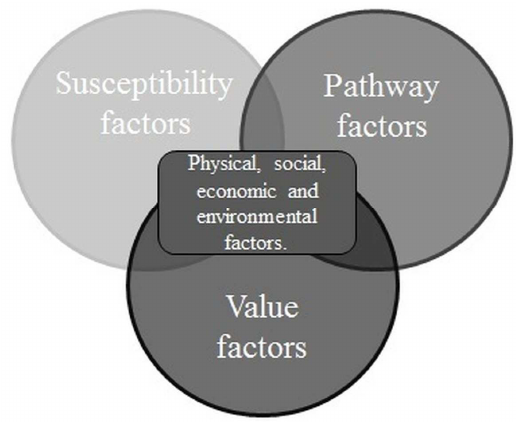
Fig. 2. Conceptualization of vulnerability for the regional vulnera- bility assessment applied in this